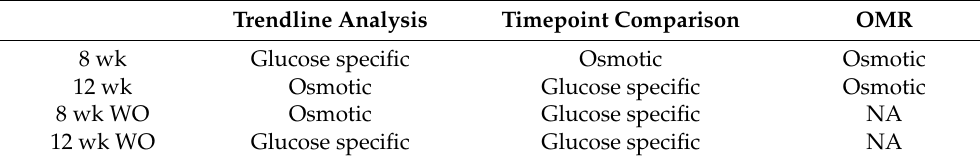
Table 1. Glucose-specific vs. osmotic pathways. This table summarizes whether a given behavior appears to be due to a general osmotic effect or a glucose-specific effect. 8 wk Full = 8 weeks of hyperglycemia; 12 wk Full = 12 weeks of hyperglycemia; 8 wk WO = 8-week washout experiment with fish exposed to glucose for 4 weeks followed by a 4-week recovery period; 12 wk WO = 12-week washout experiment with fish exposed to glucose for 8 weeks followed by a 4-week recover period. Trendline Analysis Timepoint Comparison OMR 8 wk Glucose specific Osmotic Osmotic 12 wk Osmotic Glucose specific Osmotic 8 wk WO Osmotic Glucose specific NA 12 wk WO Glucose specific Glucose